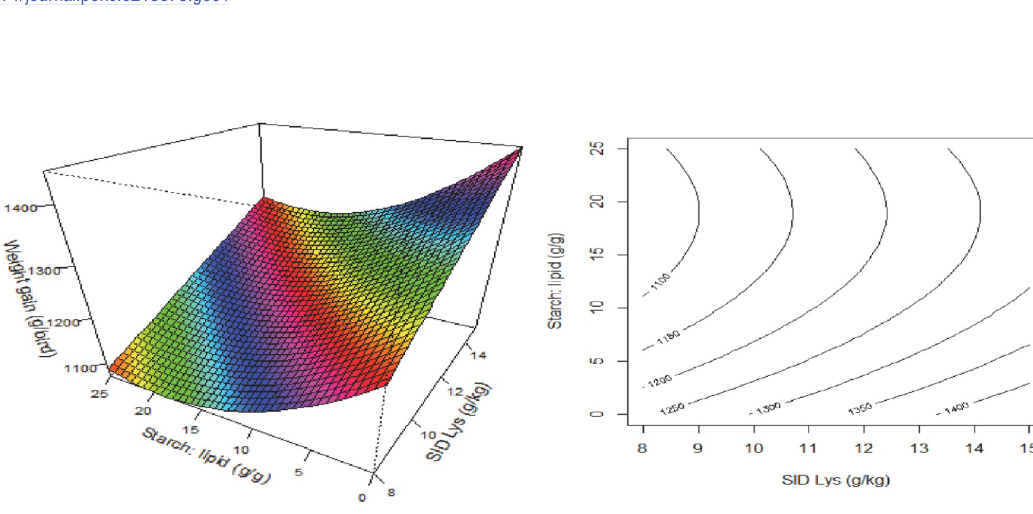
PLOS ONE | https://doi.org/10.1371/journal.pone.0213875 March 21, 2019 8 /